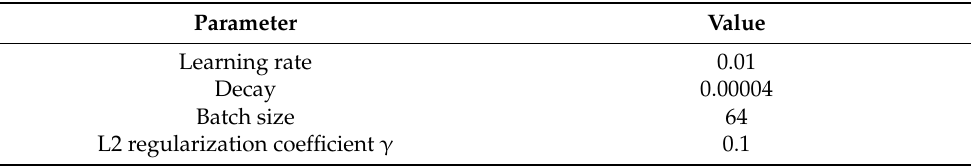
Table 3. Configuration of parameters during model